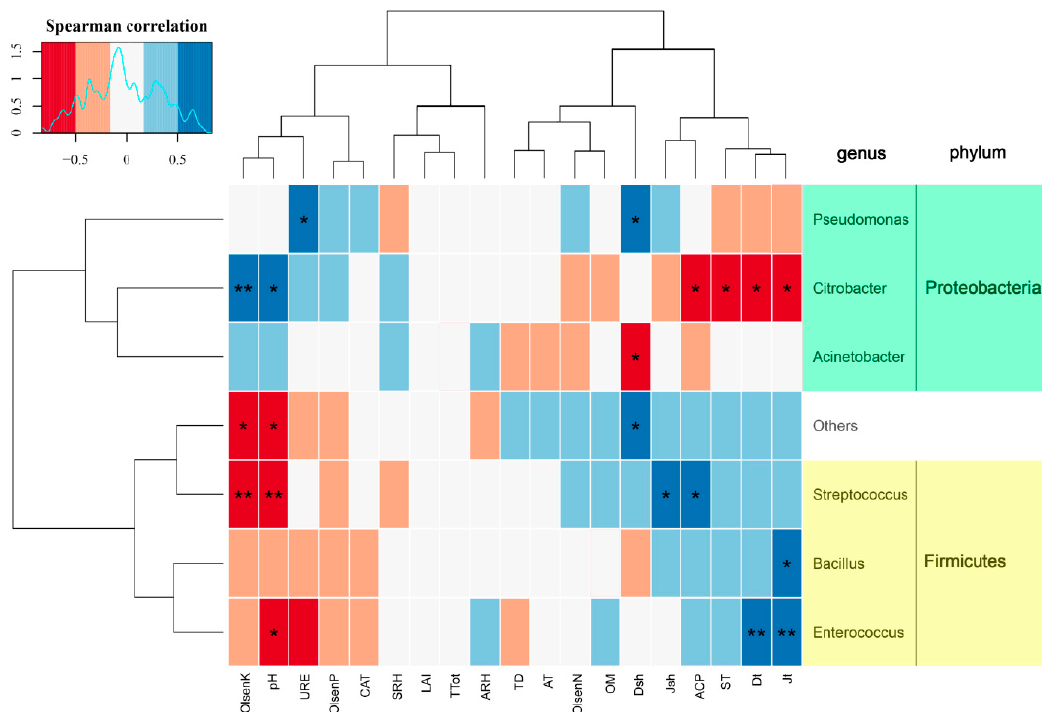
Figure 6. Heatmap displaying the correlation between environmental factors and the relative abundance of airborne bacterial communities based on the Spearman correlation coefficient. The cluster tree on the left is a species clustering tree, and the cluster tree at the top is a clustering tree of environmental factors. Red represents a negative correlation, blue represents a positive correlation, and the darker the color, the higher the correlation. The “ p ” value is the correlation test result, where * indicates p < 0.05, and ** indicates p < 0.01.